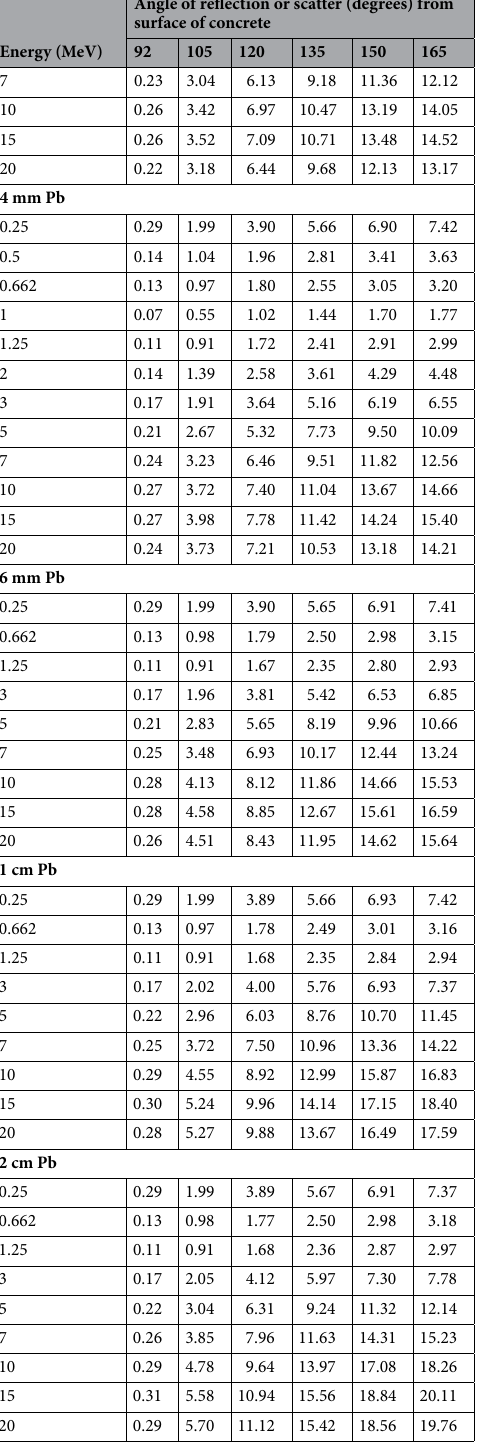
Table 2. The reflection coefficient of photons for various Pb thickness layers layered over ordinary concrete as a function of reflected angles calculated using the FLUKA code (wall-reflection coefficient). Multiply each table entry by 10 –3 (e.g., the entry 5.39 means 5.39 × 10 –3 ) with electrons cut-off = 100 keV and photons cut- off = 1 keV. The statistical uncertainties are within ± 4% (95% confidence